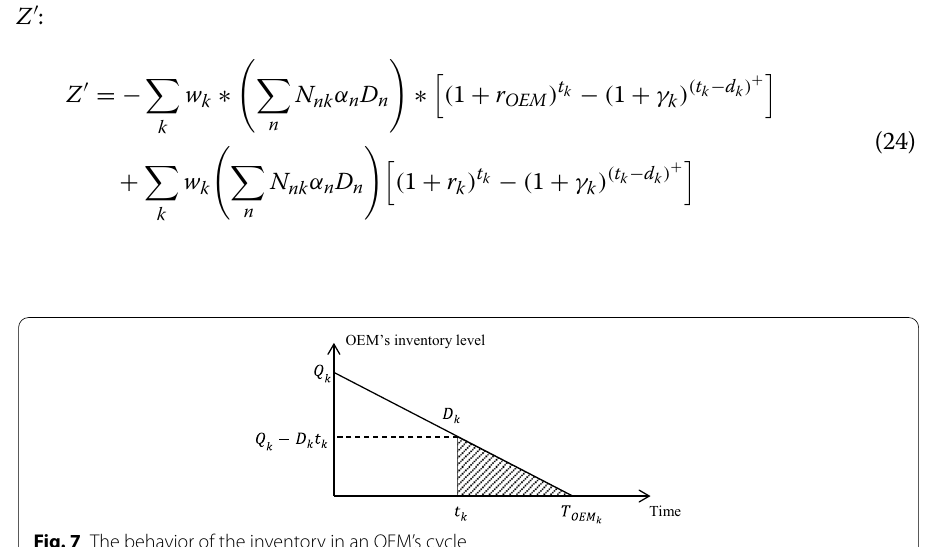
Fig. 7 The behavior of the inventory in an OEM’s